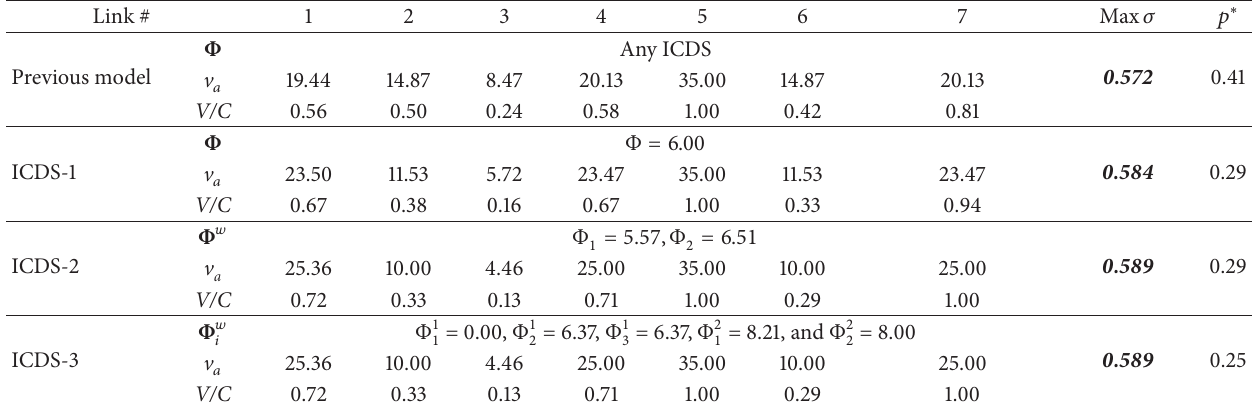
Table 1: Comparison of the optimal solutions under different ICDS.